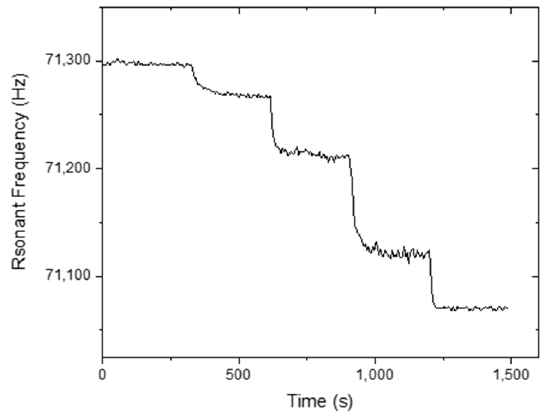
Figure 8. Frequency response of MES-1 for 5%, 25%, 54%, 85%, and 95% RH humidity levels, levels were applied step by step.